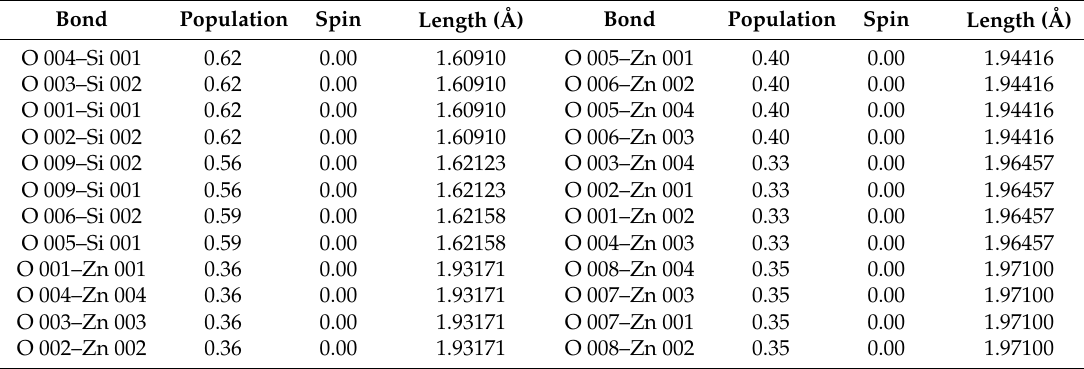
Table 1. Mulliken population value of partial bonds of